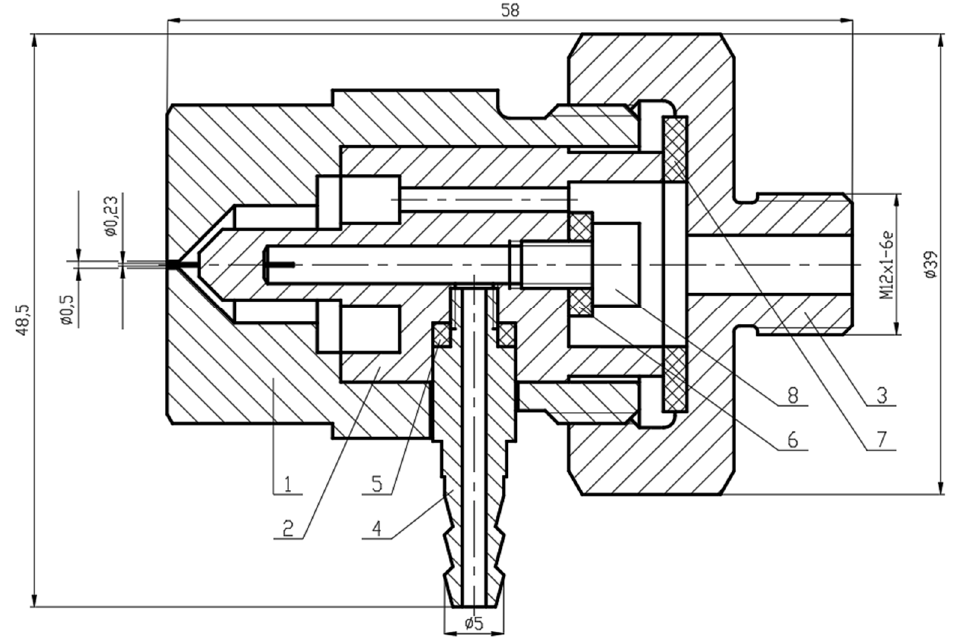
Figure 1. The spinneret design. 1, housing; 2, internal coagulant supply plug; 3, screw cap; 4, internal coagulant connection pipe; 5–7, Teflon gasket; 8,